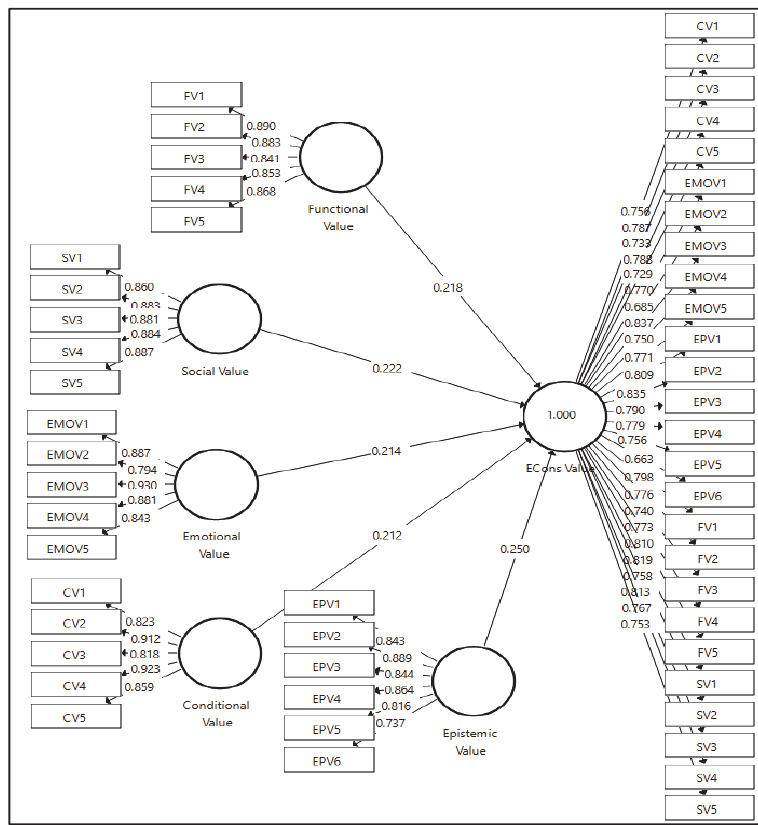
Fig. 2. Assessment of First-Order Construct’s Measurement